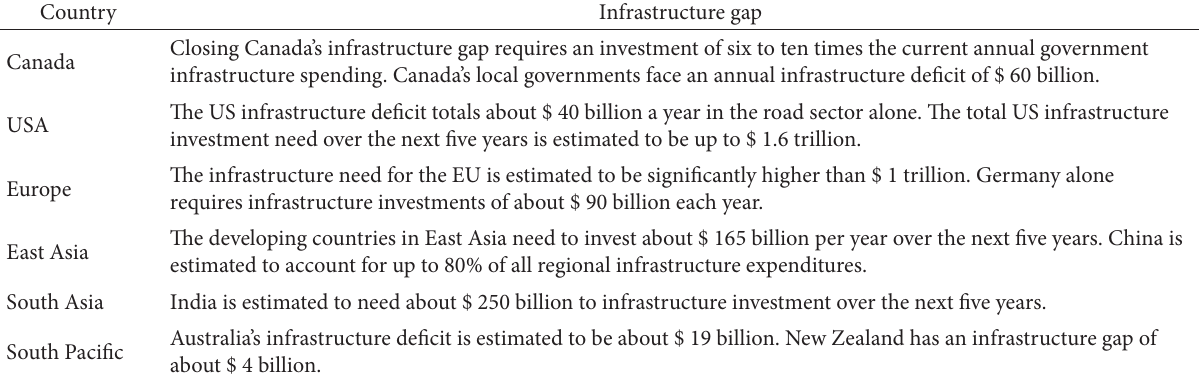
Table 1. Infrastructure funding gaps around the world (Parche 2007) Country